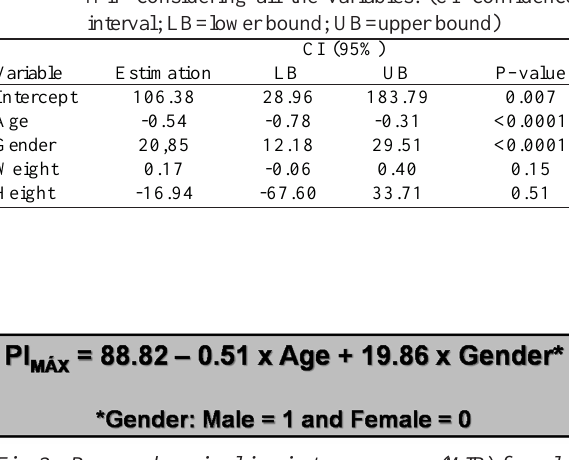
Fig. 3 - Proposed maximal inspiratory pressure (MIP) formula, according to multiple linear regression model